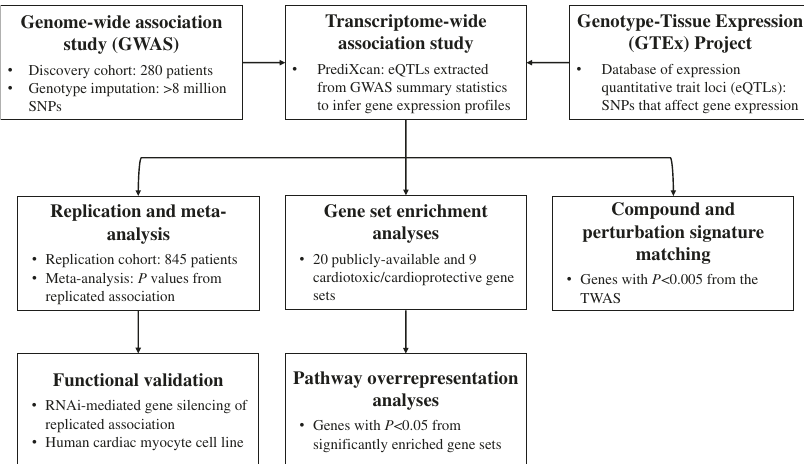
Fig. 1 Overview of methods. A TWAS was initially conducted using both previous GWAS data and GTEx gene expression information to identify differentially expressed genes associated with ACT. From there, replication of the top associations in an independent cohort and a meta-analysis as well as subsequent functional validation were conducted. Gene set enrichment and pathway analyses identi fi ed gene lists and pathways overrepresented in the TWAS. Finally, compound and perturbation gene expression signature matching was conducted to identify compounds and perturbations with similar or dissimilar expression pro fi les to the TWAS genes. Table 1. Top genes across all tissues from the ACT TWAS.